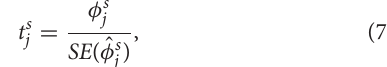
1, 2) tune the shape =